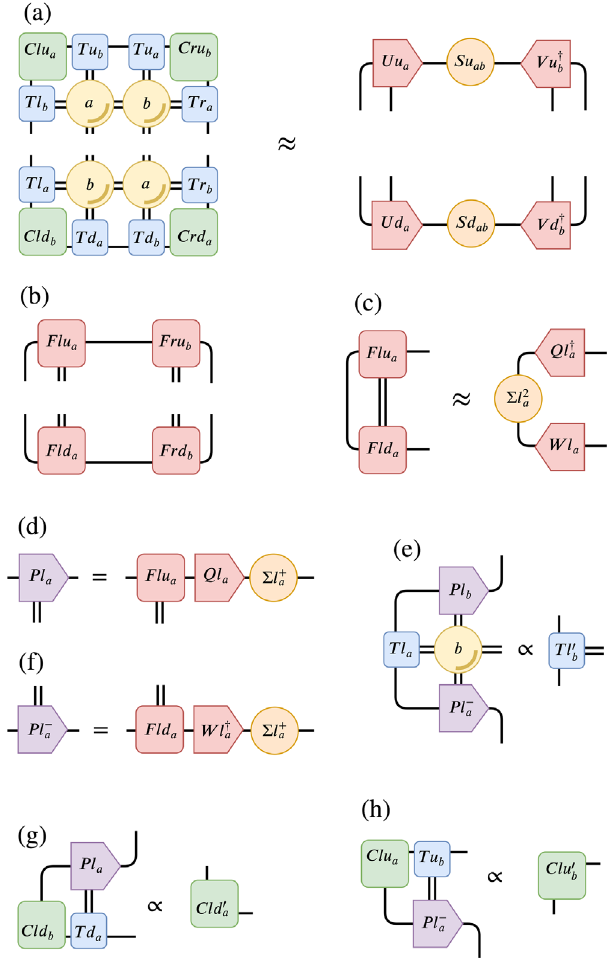
FIG. 8. Tensor diagrams representing some of the steps involved in performing the left-move component of the CTMRG algorithm used to calculate the effective environment E HS